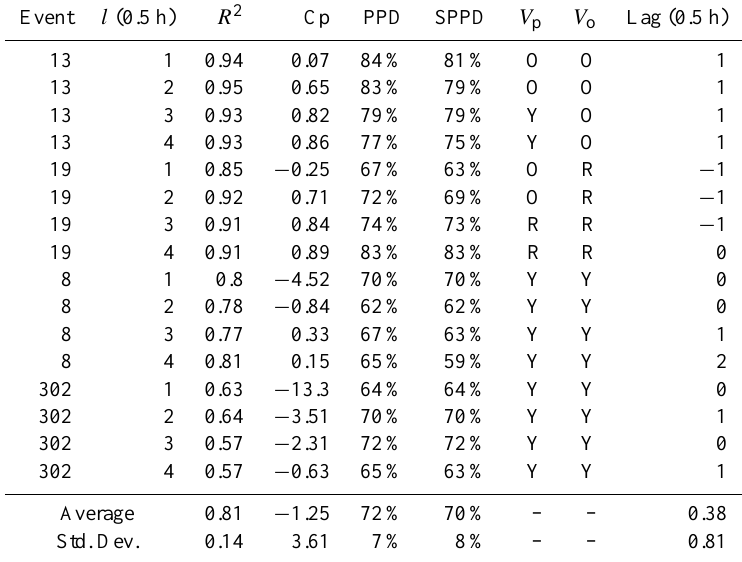
Table 7. Results output by the recurrent model ( V p : level of vigilance predicted by the model, V o : vigilance required given the observed discharge, Lag: delay between the maximum observed discharge and maximum predicted discharge).